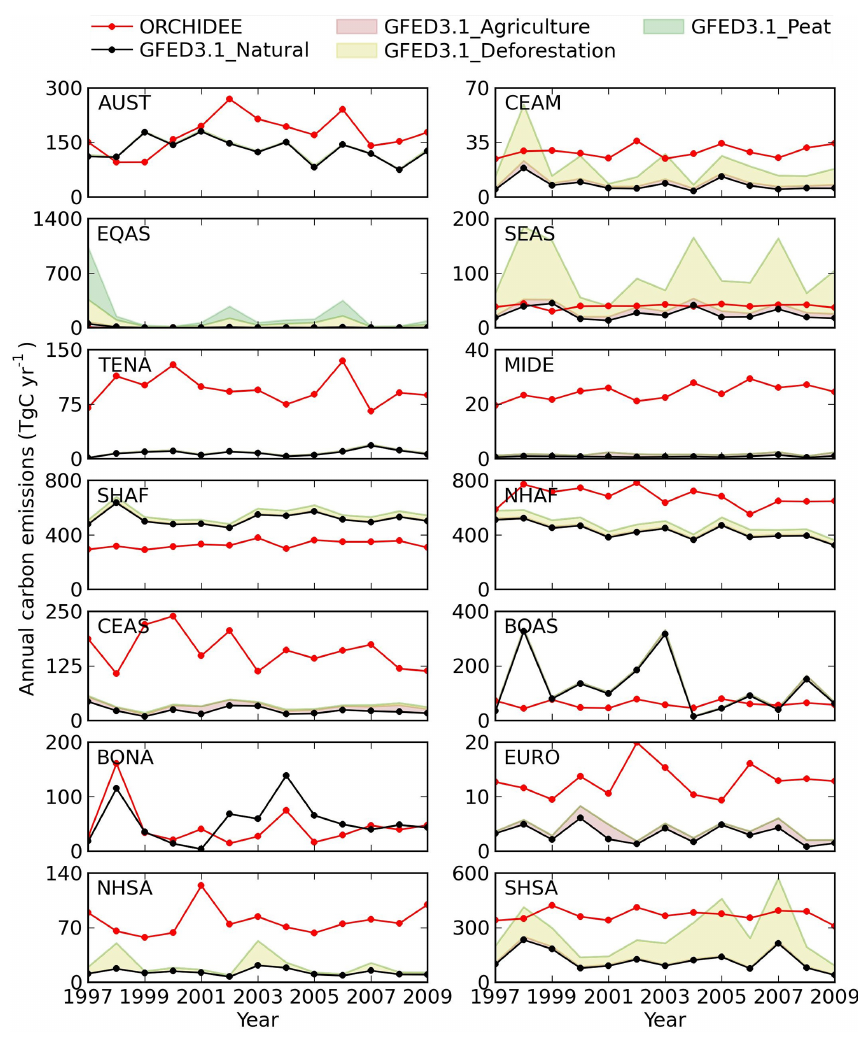
Figure 4. Annual fire carbon emissions simulated by ORCHIDEE and from the GFED3.1 data for 1997–2009 for the 14 different GFED regions. The 14 GFED regions are BONA: boreal North America; TENA: temperate North America; CEAM: Central America; NHSA: Northern Hemisphere South America; SHSA: Southern Hemisphere South America; EURO: Europe; MIDE: Middle East; NHAF: Northern Hemisphere Africa; SHAF: Southern Hemisphere Africa; BOAS: boreal Asia; CEAS: central Asia; SEAS: Southeast Asia; EQAS: equatorial Asia; and AUST: Australia and New Zealand. Refer to Fig. S5 for their